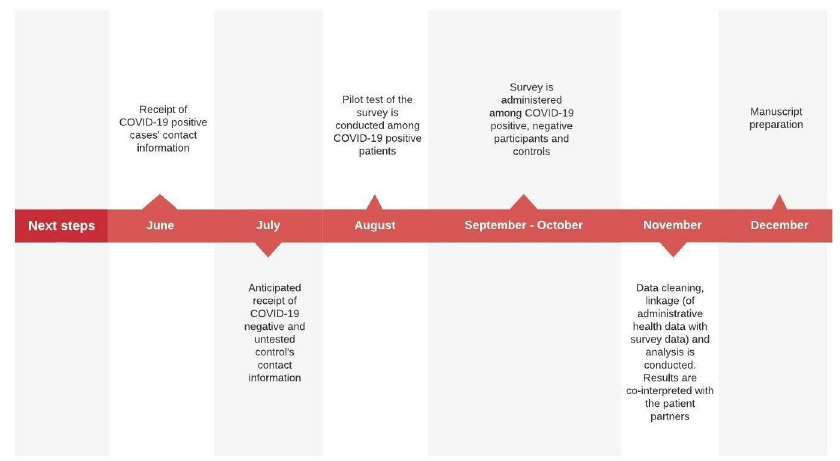
Fig 4. Anticipated timeline of project